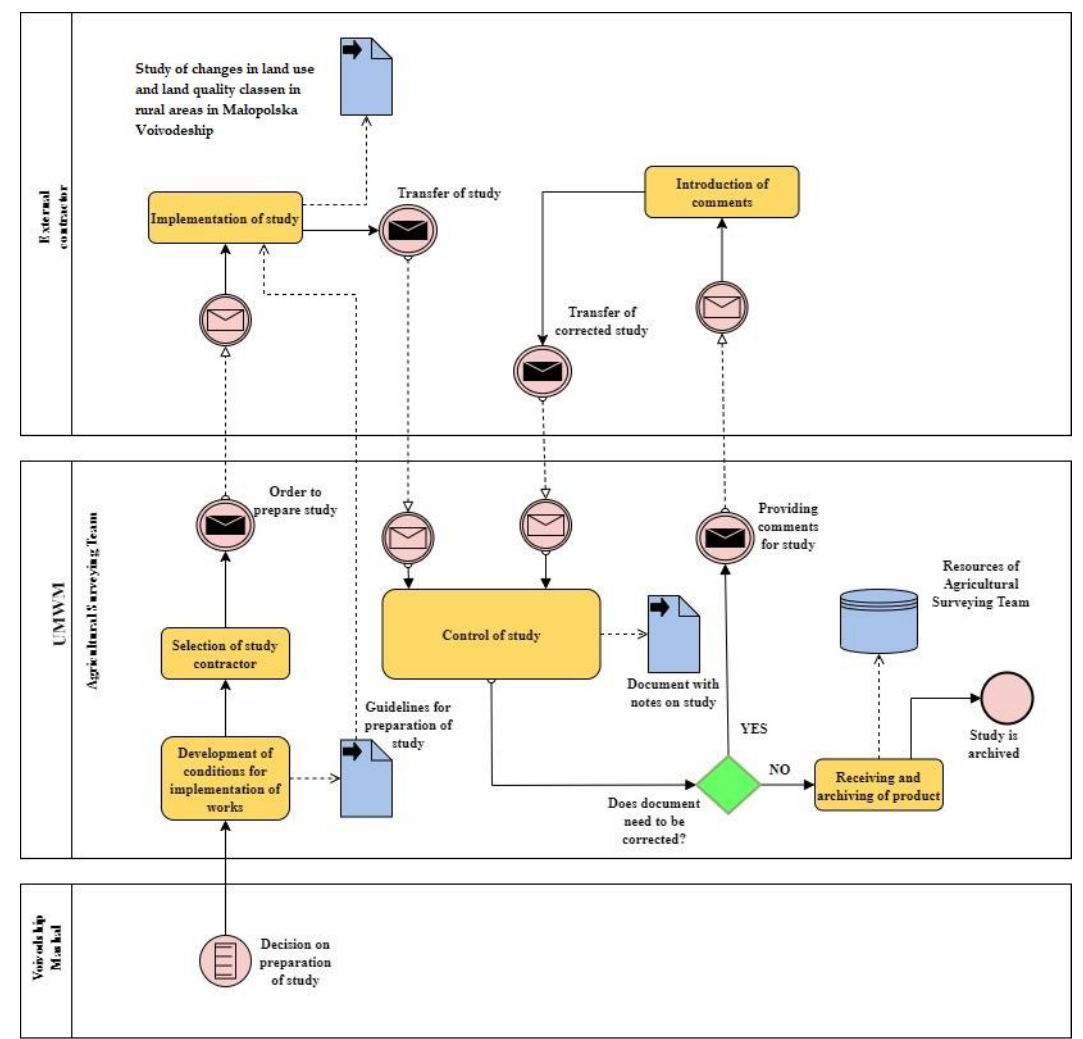
Figure 4. Study on changes in land use and land quality classes. Source: own study.